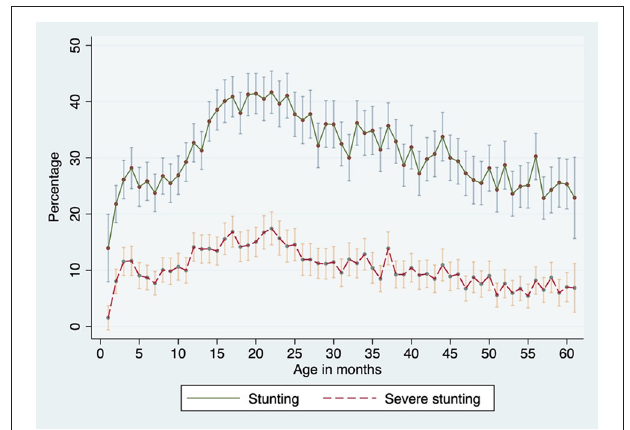
FIGURE 1 | Prevalence of stunting over children’s age in 2019. Source: Own elaboration based on Caritas Venezuela data. 95% confidence intervals. Stunting was defined according to the 2006 WHO growth